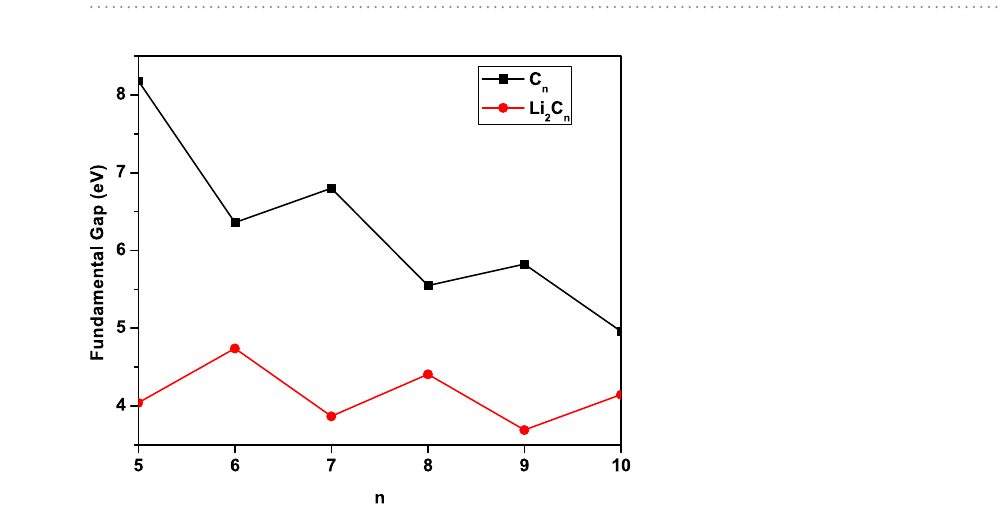
Figure 3. ( a ) Vertical ionization potential and ( b ) vertical electron affinity for the lowest singlet state of C n / Li 2 C n as a function of the chain length, calculated using TAO-BLYP-D.